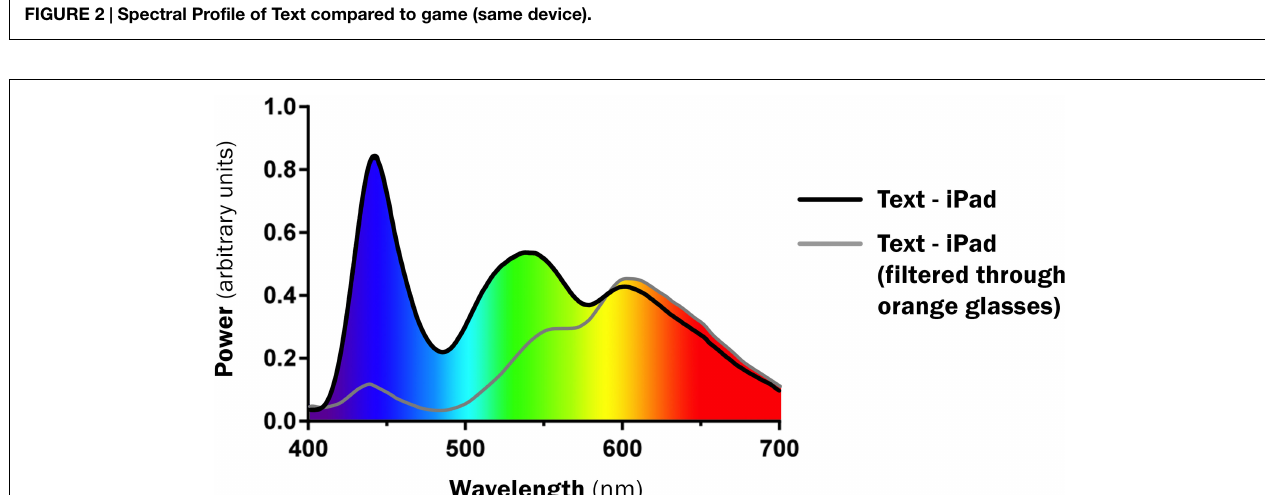
FIGURE 3 | Spectral Profile demonstrating impact of ‘blue-blocking’ glasses .